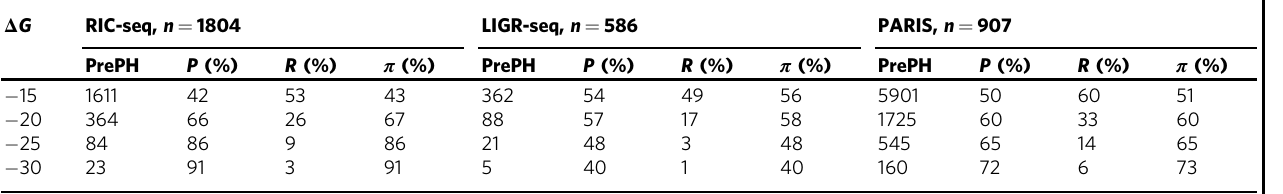
Theprecision( P )andrecall( R )aretheproportionofPCCRssupportedbytheexperimentalmethodandtheproportionofexperimentalinteractionssupportedbyPCCRs,respectively. π istheconditional probability of predicting the interacting CCR partner correctly given that another CCR in a pair has been predicted correctly. The column “ PrePH ” shows the number of PCCRs that satisfy the criteria for comparison. The number of structures in each experimental method is denoted by n .